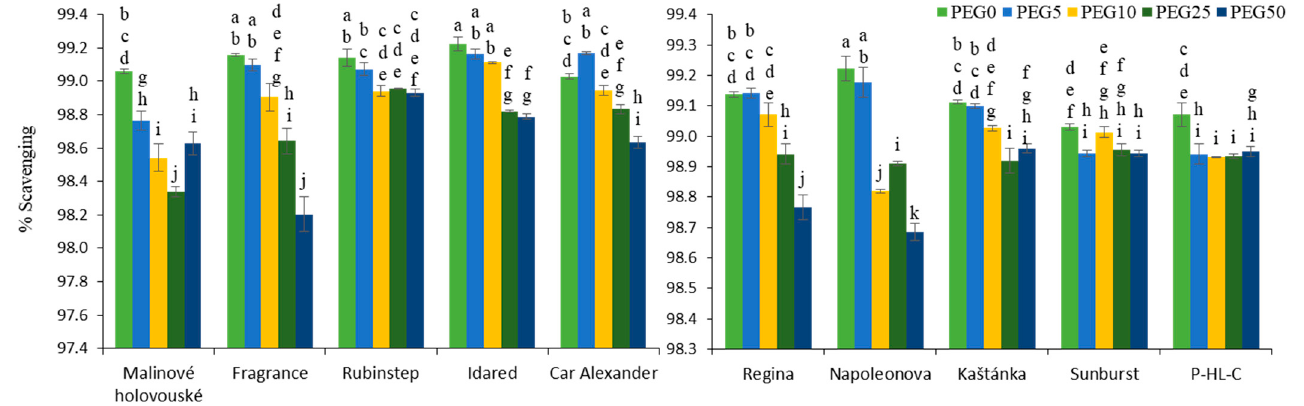
Figure 5. Effect of PEG-6000 concentration on scavenging activity of DPPH radical (%) for in vitro culture of apple ( left )